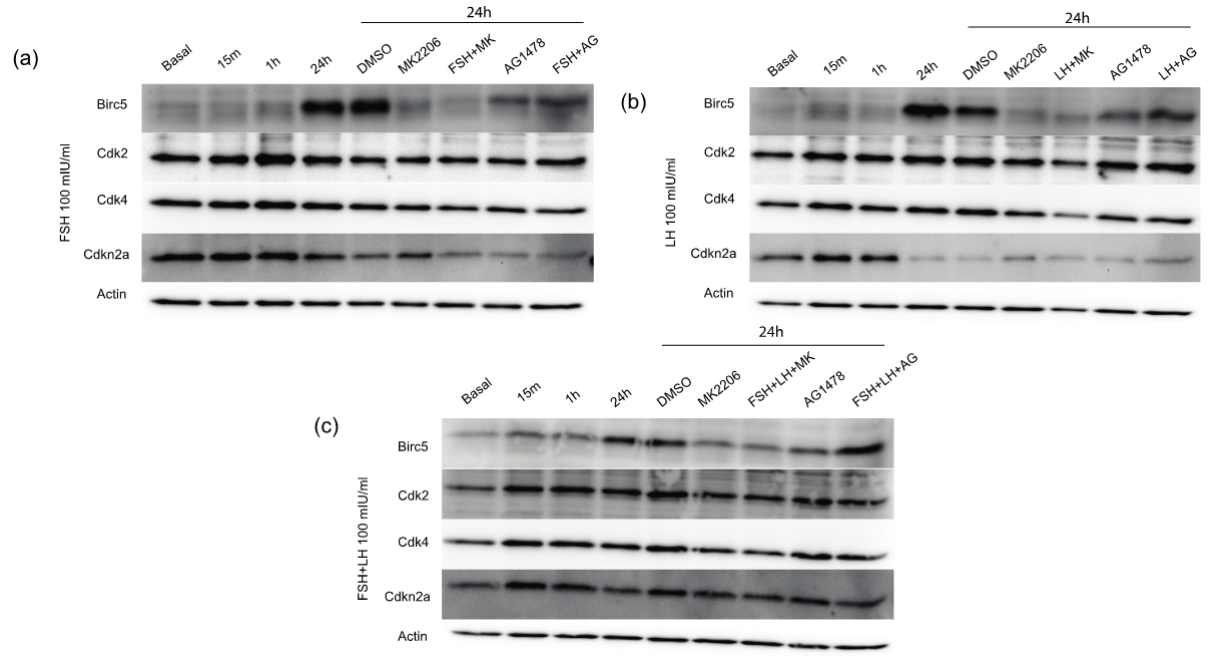
Figure 5. Gonadotropins regulate proliferative and anti-apoptotic signaling pathways in normal OSE downstream of Akt and EGFR. MOSE cells treated for 15 min, 1 h and 24 h with ( a ) FSH 100 mIU/mL; ( b ) LH 100 mIU/mL and ( c ) FSH+LH 100 mIU/mL was analyzed for Birc5, cdk2, cdk4, and Cdkn2a. MOSE cells were treated for 24 h with gonadotropins supplemented with the Akt inhibitor MK-2206 5  M and AG1478 100 nM. Protein was normalized to actin. All gels were run in 3 independent experiments with a representative image